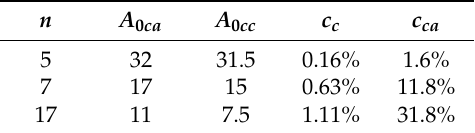
Table 4. The difference between actual and the calculated value of current